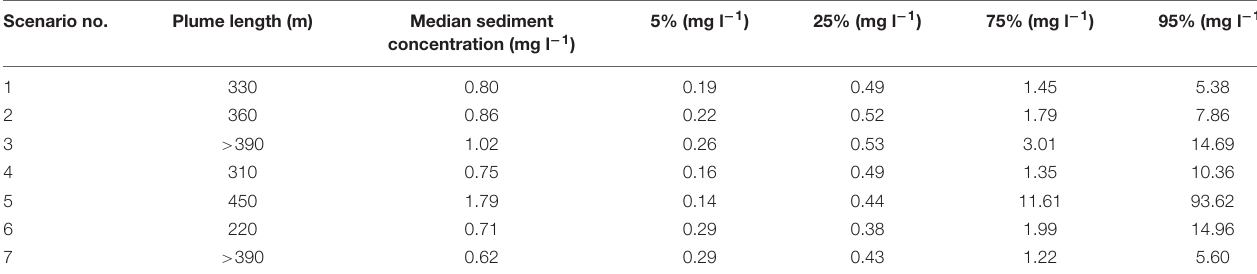
FIGURE 7 | Accumulated sediment (g m - 2 on log scale) at the end of the trawling activities in Lovns Bredning for the different scenarios (A–G) (nos. 1–7 in Table 3 ). The hatched area indicates the location of the eelgrass box. Black circles indicate the position of loggers. TABLE 4 | Plume length (m) and intensity expressed as the median (50%) and the 5, 25, 75, and 95% percentiles of suspended sediment concentration in the water column 0–1 h after dredging. Scenario